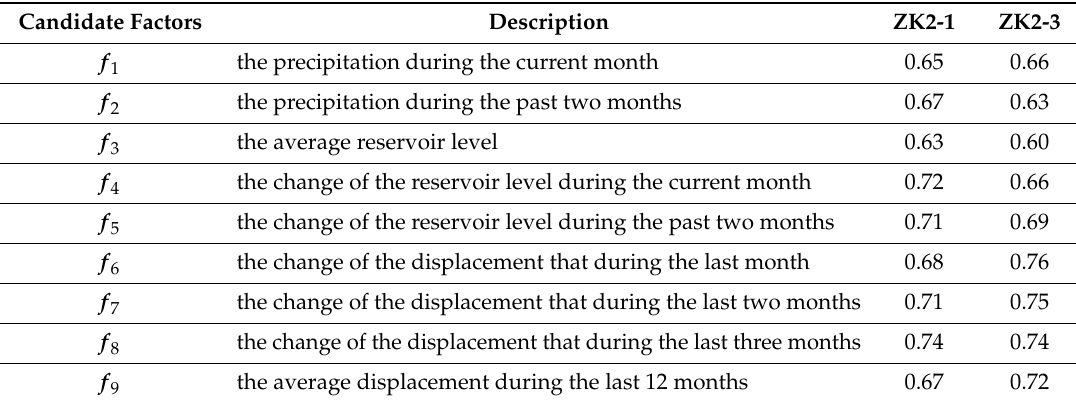
Table 2. Relation degree between the periodic terms and the candidate